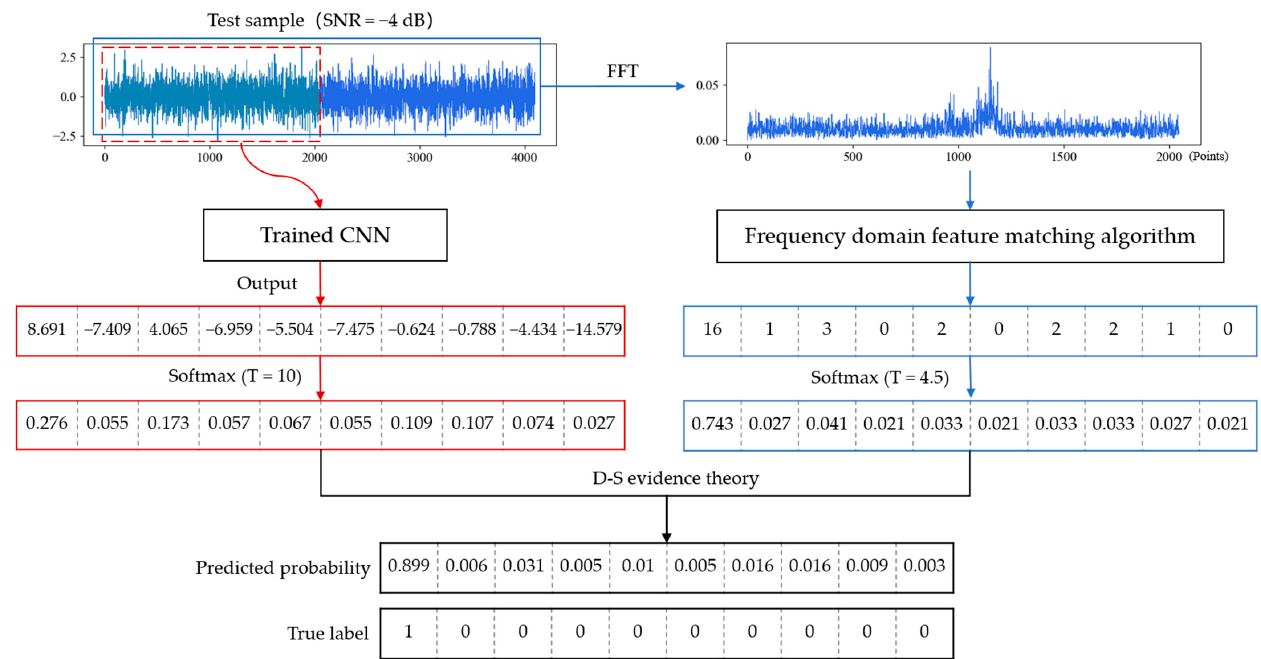
Figure 15. Process and result of model fusion when testing on a noisy sample with a SNR of − 4 dB. After smoothing, the highest probability is not too sharp, and some possibilities are given to the other categories. The CNN and FDFM algorithm can provide different infor- mation, so the diagnosis results are more reliable after fusion. Experiments were carried CNN-FDFM. The models were trained with noise-free signals and tested with noisy sam- ples with different SNRs from − 10 dB to 8 dB. For each model, ten trials were carried out, and the average values were taken as the results. The specific results are shown in the